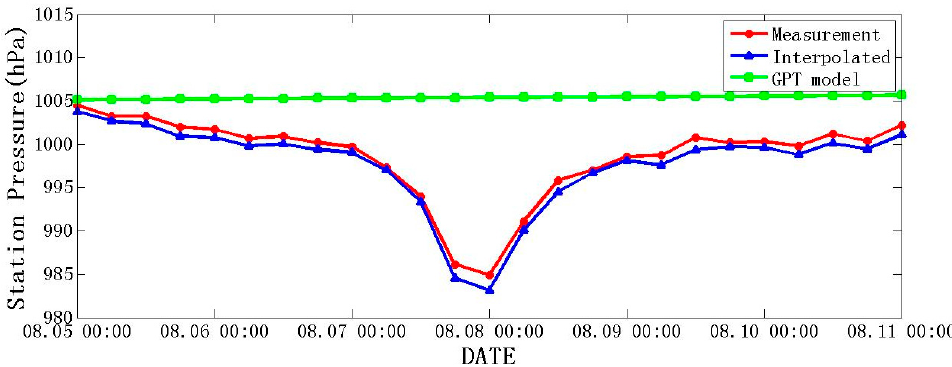
Figure 6. ZJZS station’s surface pressure time series respectively from observation, interpolation, and the GPT model. The period is 5 to 11 August 2012, during which the Haikui typhoon landed in Ningbo City, Zhejiang Province, China.